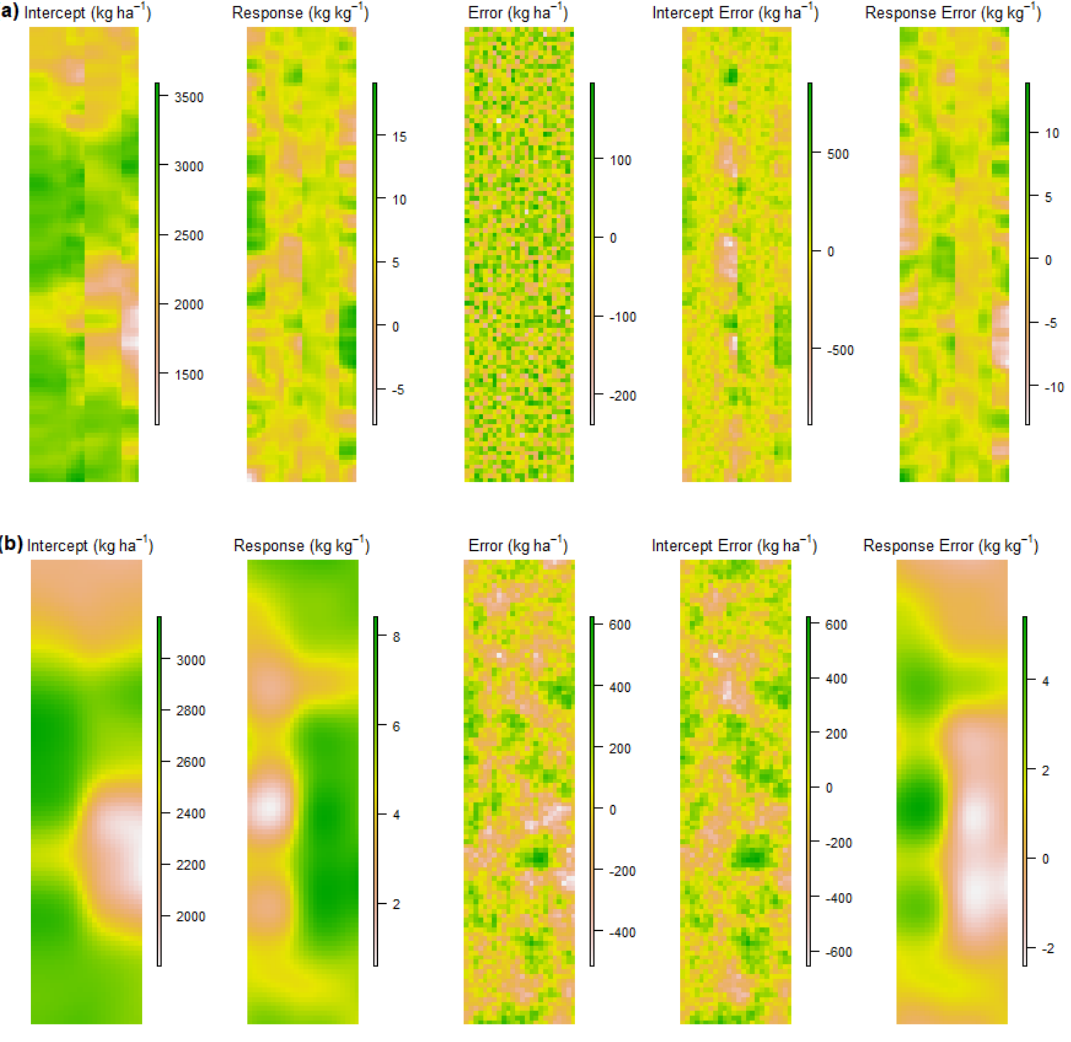
Figure 6. Results for data simulated with global linear response using bandwidth selection by ( a ) minimal corrected Akaike Information Criterion (AICc) and ( b ) based on experimental design.